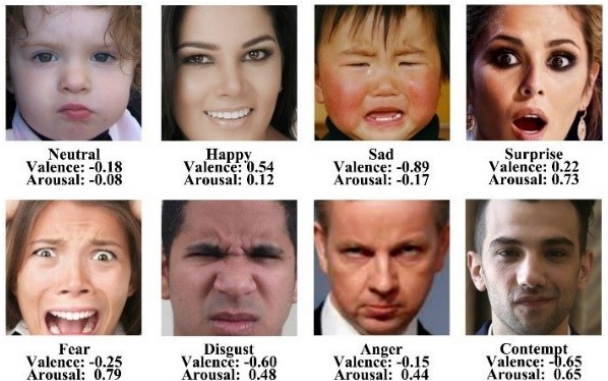
Figure 3. Examples of the eight categories of facial expressions (Neutral, Happy, Sad, Surprise, Disgust, Fear, Anger and Contempt) and their values of valence and arousal from the AffectNet